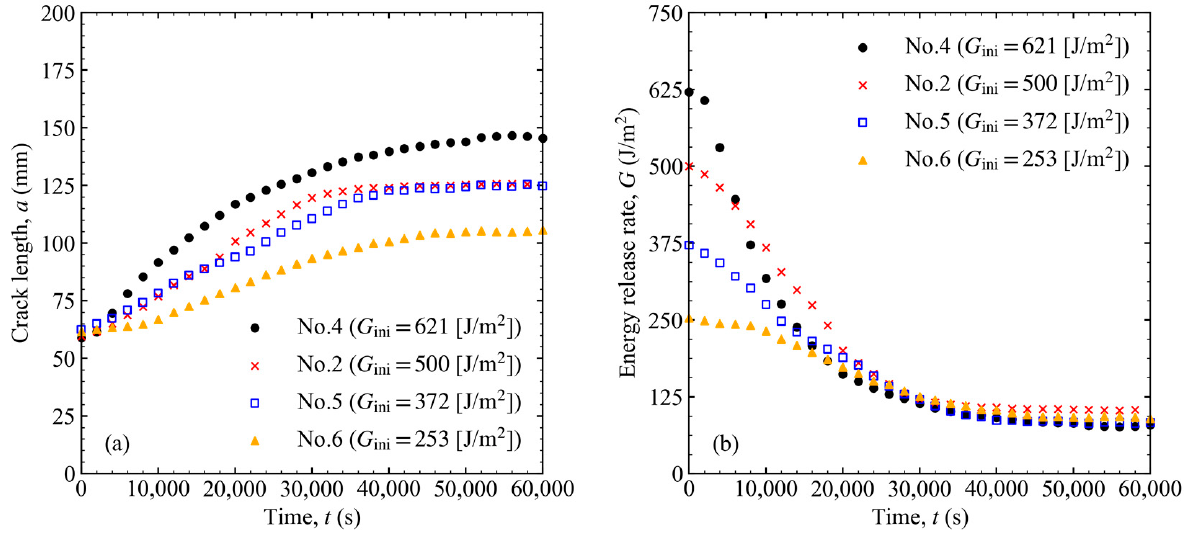
Figure 8. ( a ) Crack length and ( b ) energy release rate variation over time when the initial load level